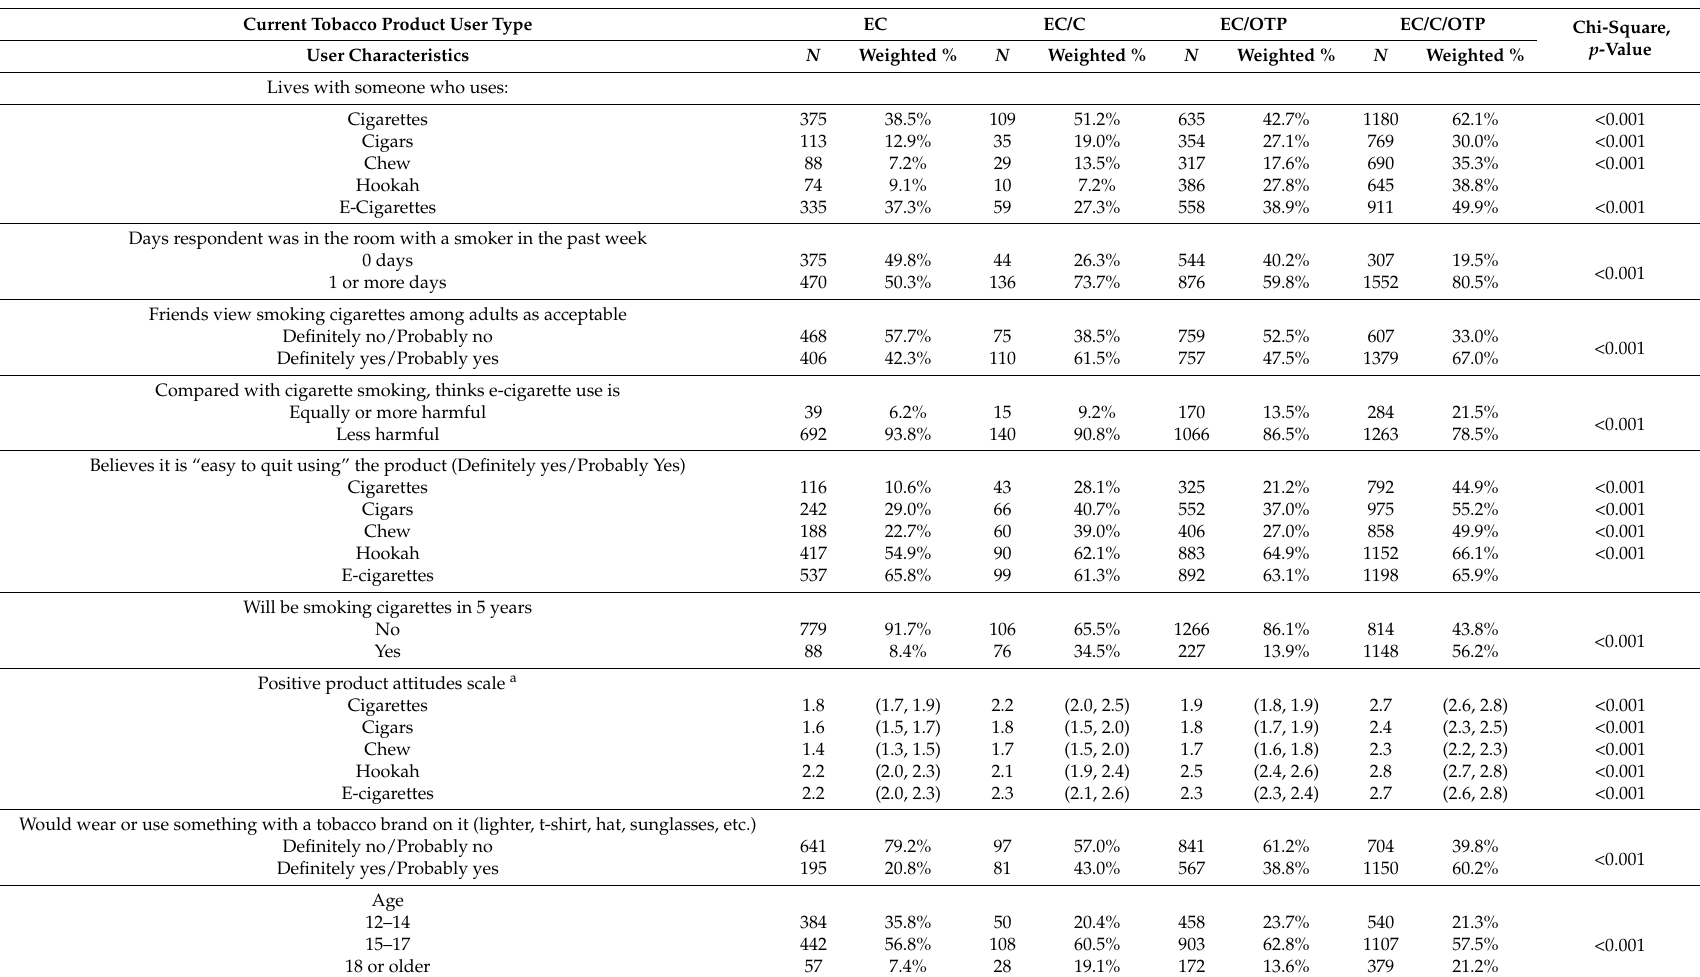
Table 2. Characteristics among Types of Current E-cigarette Using Youth in Florida, Florida Youth Tobacco Survey,